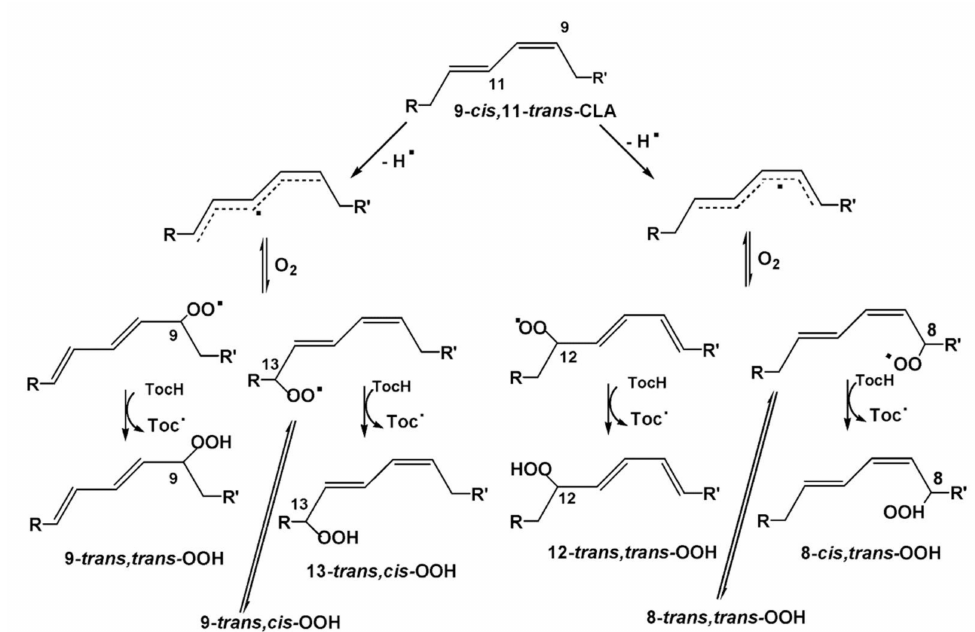
Figure 22. Mechanism proposed for the autoxidation of conjugated methyl 9- cis ,11- trans octadeca- dienoate in the presence of α -tocopherol. Reprinted with permission from [10,100]. Copyright 2002,